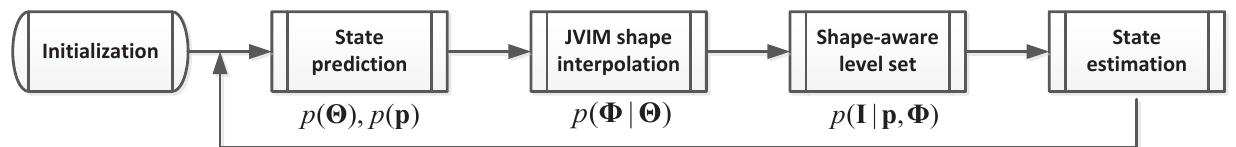
Figure 2. Flowchart for